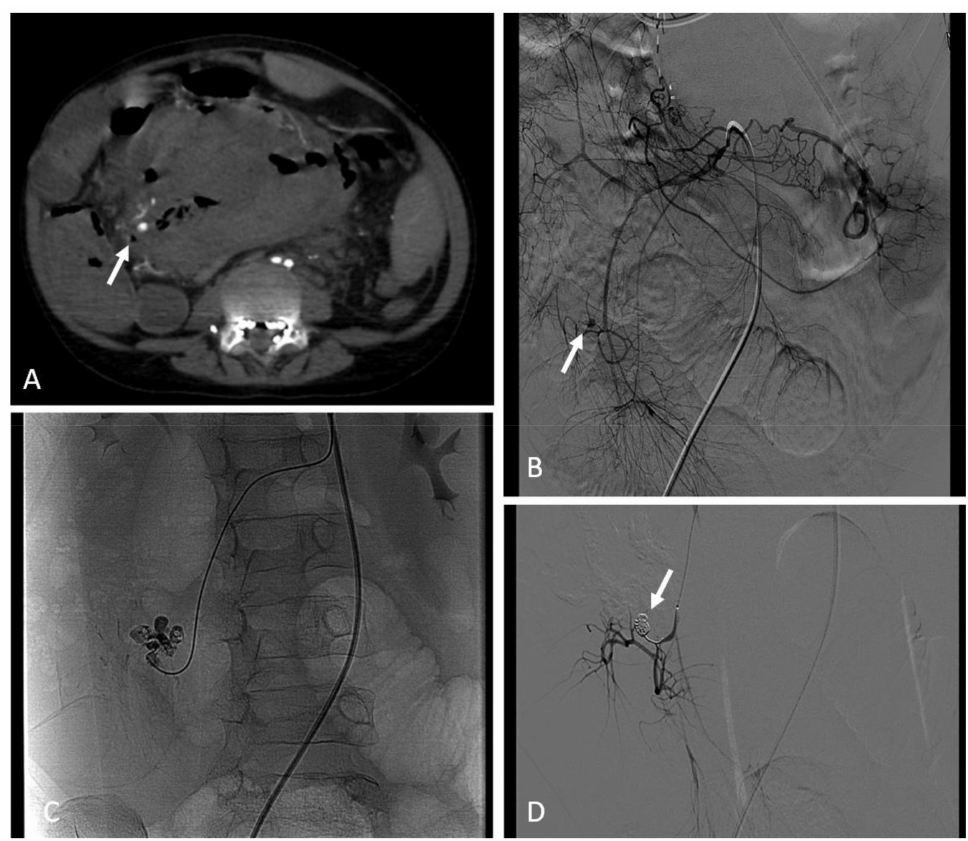
Figure 3. Transcatheter coil embolization of spontaneous abdominal bleeding in a lymphoprolif- erative disorder of the ileum in a 10-year-old female. ( A ) Axial CTA image shows a large necrotic mass with hyperdense component, consistent with recent bleeding within the mesentery, with a small arterial pseudoaneurysm (arrow). ( B ) Selective superior mesenteric artery DSA performed with a 4F catheter shows the small pseudoaneurysm (arrow) affecting the ileocolic artery. ( C ) Fluoro- scopic image shows contrast extravasation due to pseudoaneurysm rupture during superselective coaxial 2.7F microcatheterization of the ileocolic artery. ( D ) Control DSA image after superselec- tive 3-mm coil (arrow) embolization shows disappearance of the pseudoaneurysm with no longer contrast